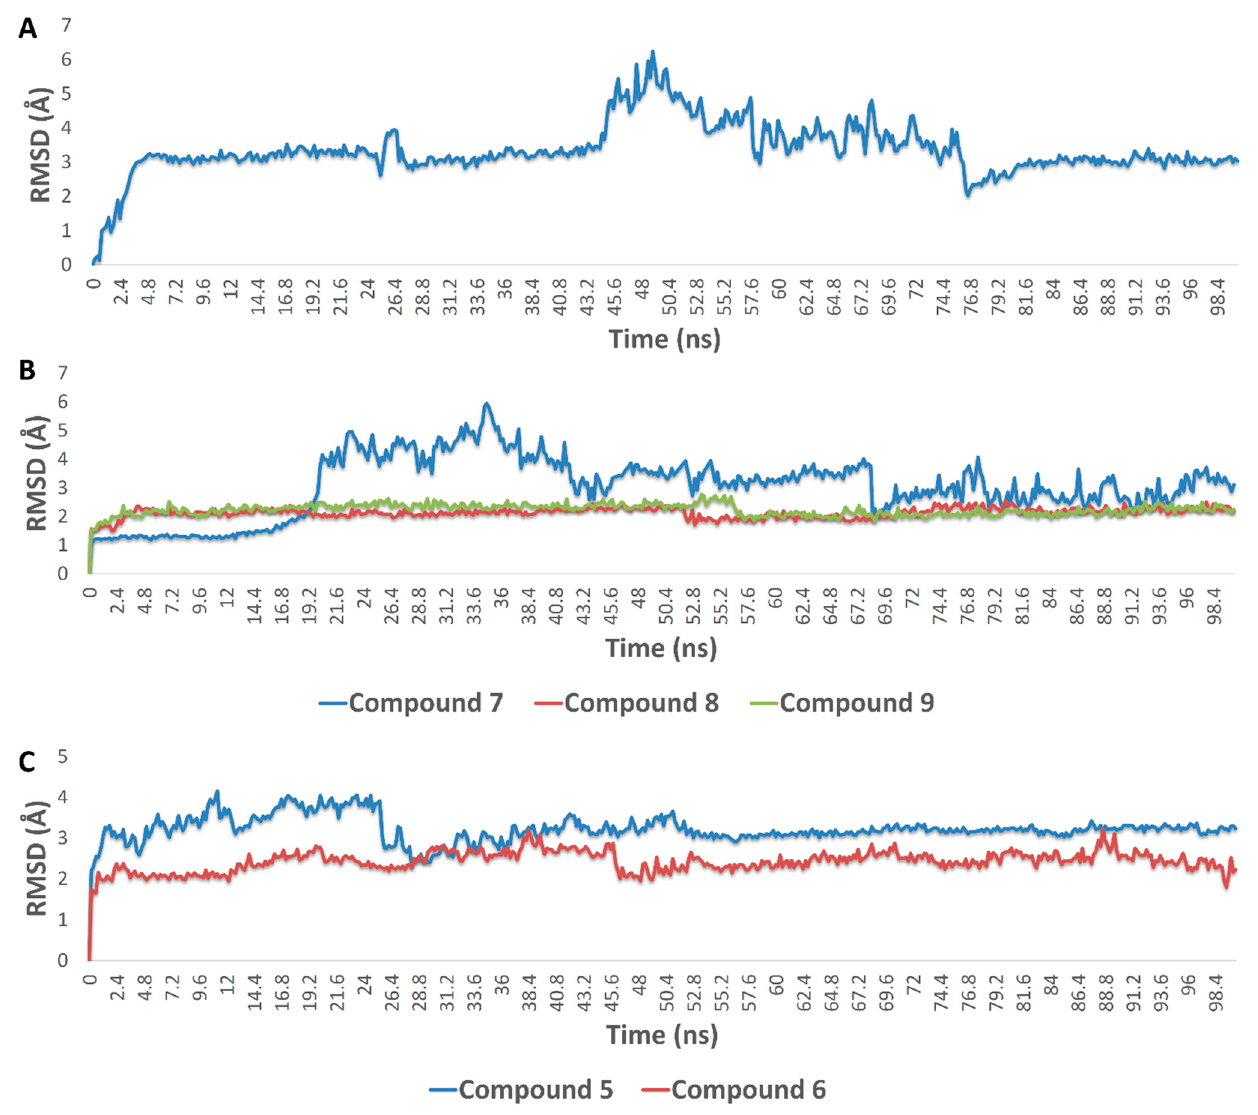
Figure 17. ( A ) RMSDs of compound 6 inside the active site of MAP kinase ERK1 (ERK1) over 100 ns MDS; ( B ) RMSDs of compounds 7 – 9 inside the active site of matrix metalloproteinase-9 (MMP9) over 100 ns MDS; ( C ) RMSDs of 5 and 6 inside the active site of cytochrome P450 19A1 (aromatase, CYP19A1) over 100 ns MDS.